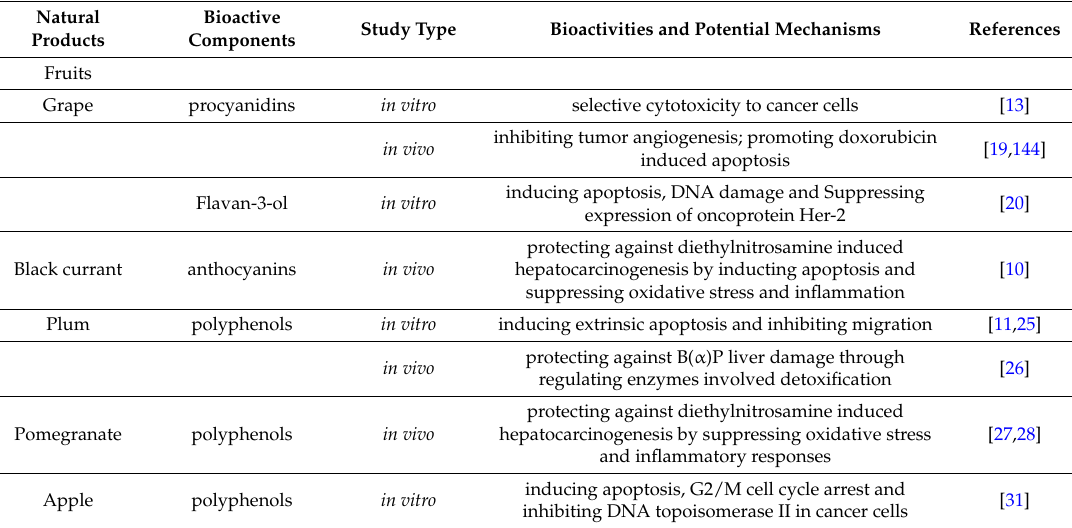
Figure 3. Some effects of dietary natural products against liver cancer. Table 1. Effects of dietary natural products against liver cancer.